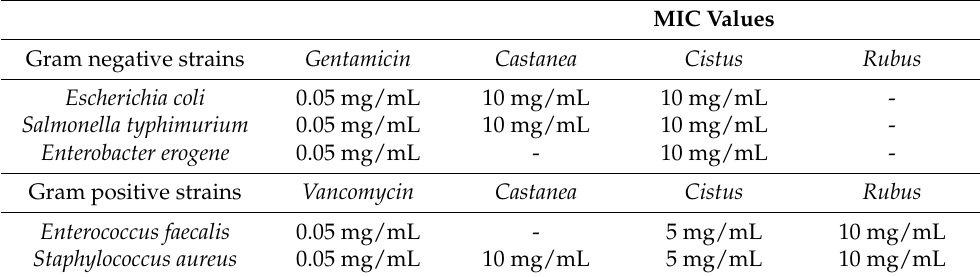
Table 1. Minimum inhibitory concentration (MIC) values of Castanea, Cistus , and Rubus bee-pollen extracts on selected pathogen strains growth (O.D. 600 nm). Gentamicin and vancomicyn were used as target